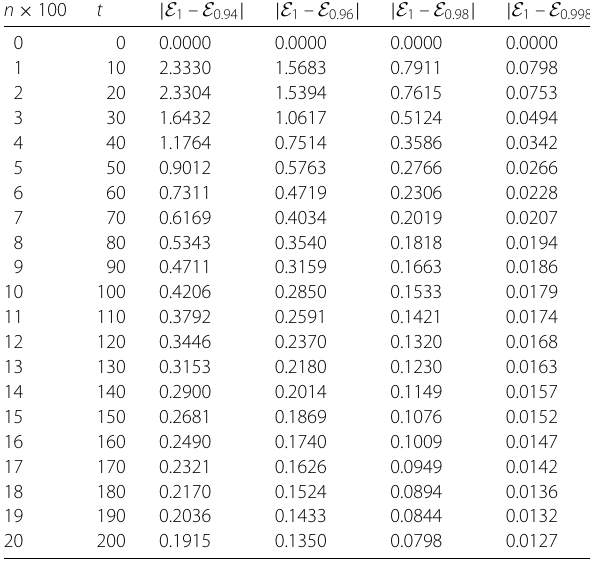
Table 8 The values of | E 1 – E φ | for φ = { 0.94,0.96,0.98,0.998